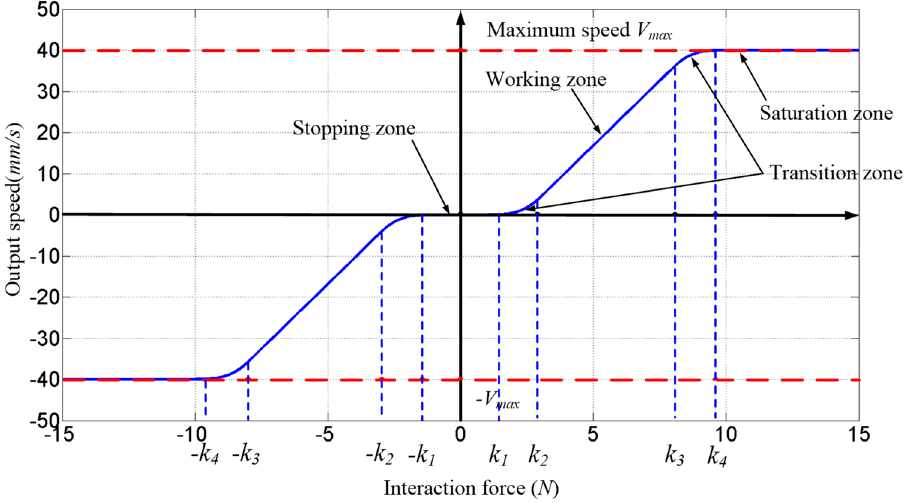
Figure 8. Admittance mapping based on the piecewise function.